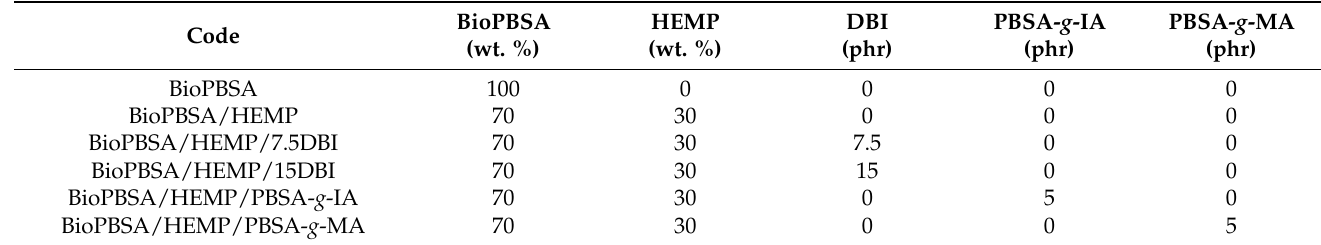
Table 1. Summary of compositions according to the weight content (wt.%) of BioPBSA/HEMP and parts per hundred resin ( phr ) of different